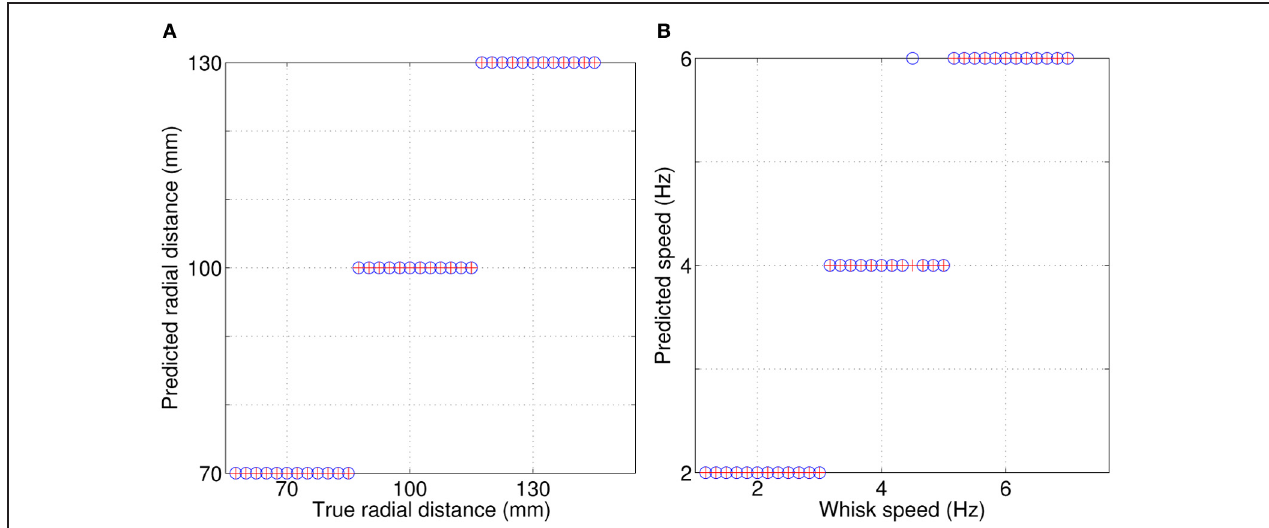
FIGURE 8 | Simultaneous classification of radial distance to contact (A), and whisk speed (B) on SCRATCHbot. Red crosses = true values, blue circles = classifications. Only one contact is miss-classified in the 36 contact test-dataset.